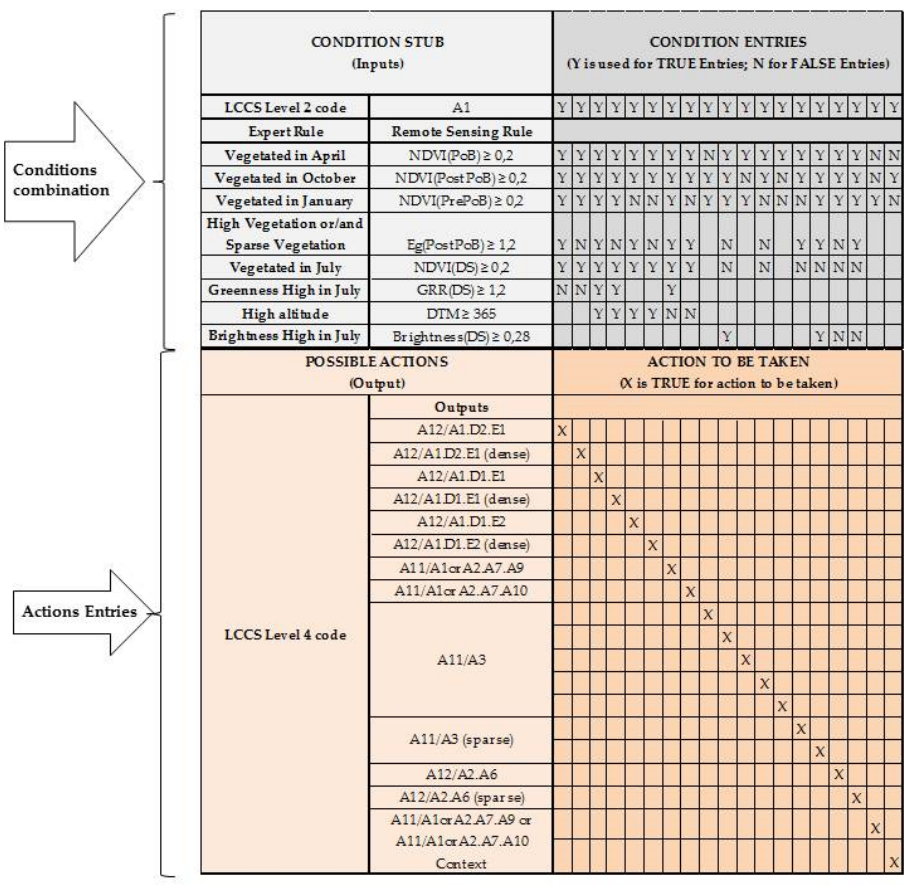
Figure 6. Decision table for LCCS Level 4 Figure 5. Decision table for LCCS Level 4 mapping.